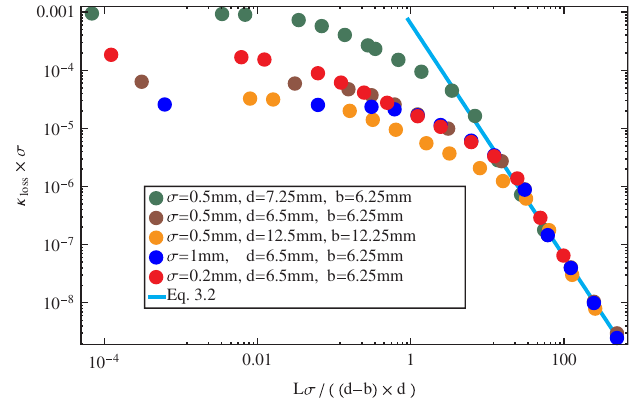
(cid:7) (cid:1) , [ V - m = pC ] loss